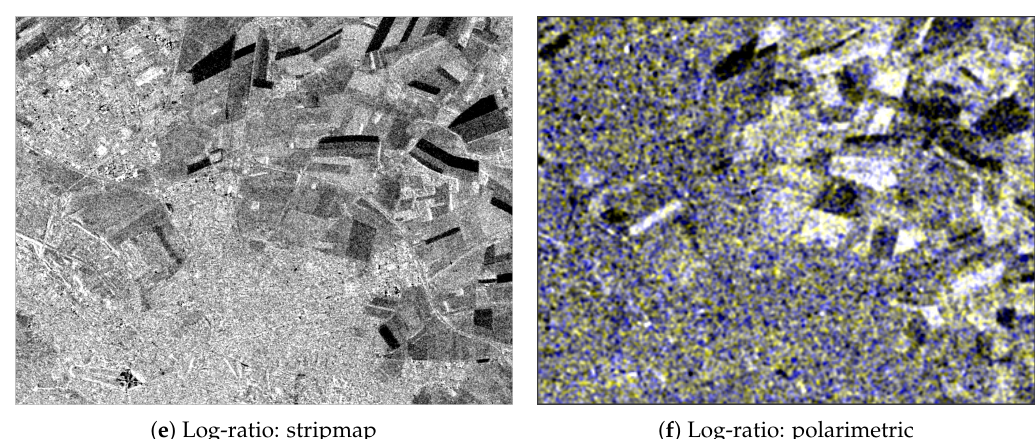
Figure 3. COSMO-SkyMed dataset and log-ratio images: single-channel stripmap (left) and RGB false color compositions of the polarimetric channels (right). The false color composition is such that R = G = HH and B = VV. The resolution ratio is four, but the images have been resized to the same size for visualization